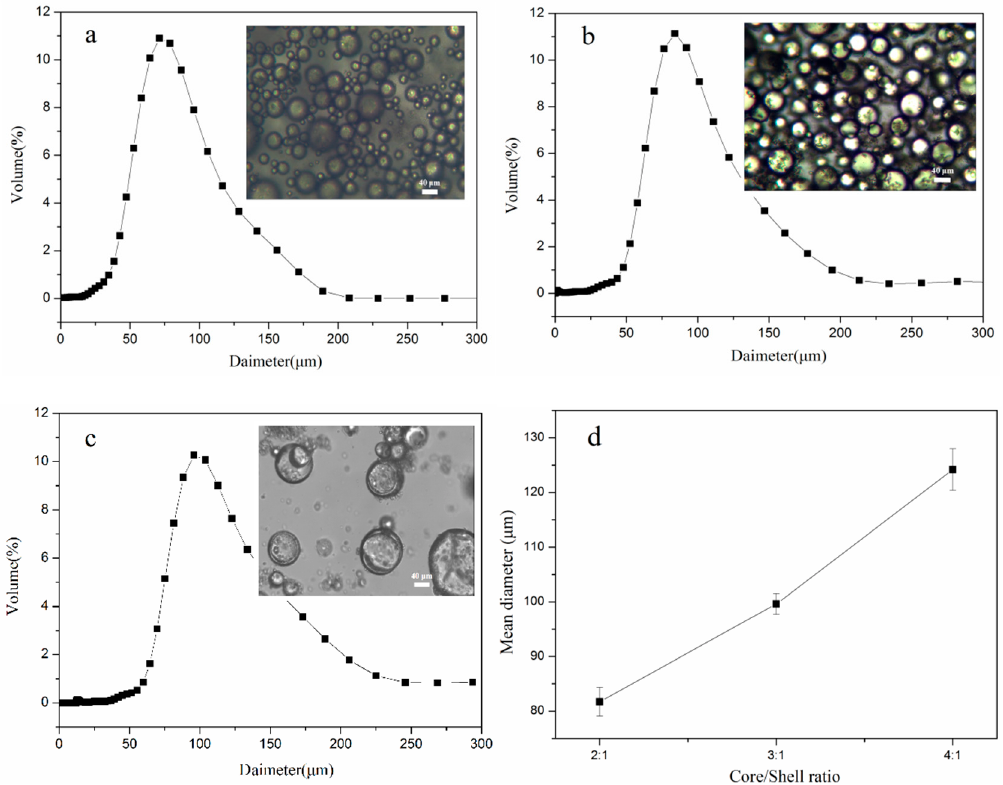
Figure 3. The size distributions and OM images of TO-loaded microcapsules with a core/shell ratio of ( a ) 2:1, ( b ) 3:1, and ( c ) 4:1, and ( d ) mean diameter of microcapsules with different core/shell mass ratios.